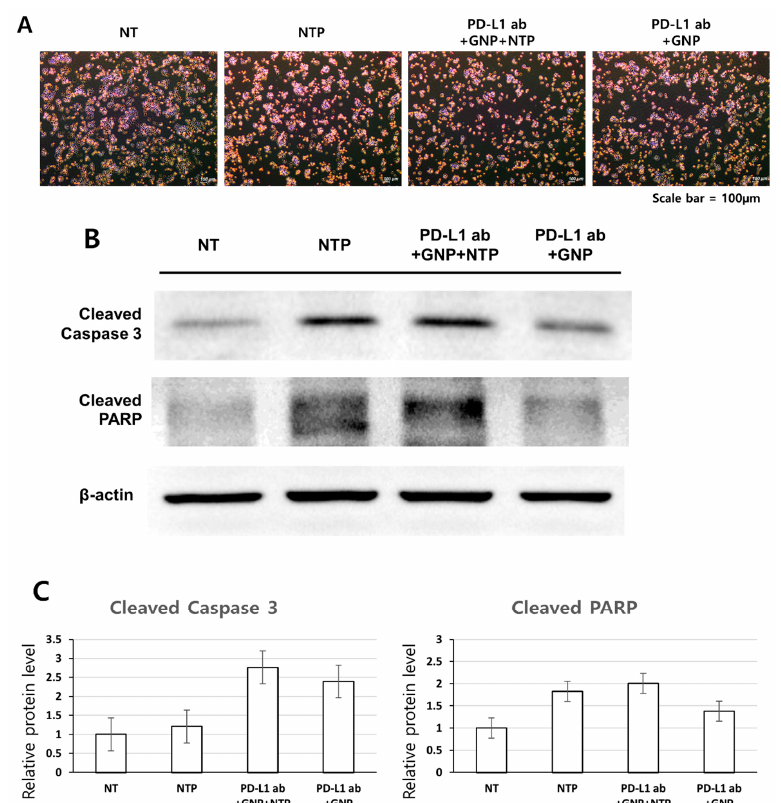
Figure 6. ( A ) Microscopic images. ( B ) Western blot analysis of cleaved caspase-3 and cleaved PARP. ( C ) Relative expression levels of cleaved caspase-3 and cleaved PARP protein in SCC-25 cells with NTP, PD-L1 ab + GNP + NTP and PD-L1 ab + GNP treatments. Abbreviations: NT, nontreatment; ab, antibody; GNP, gold nanoparticle; NTP, nonthermal